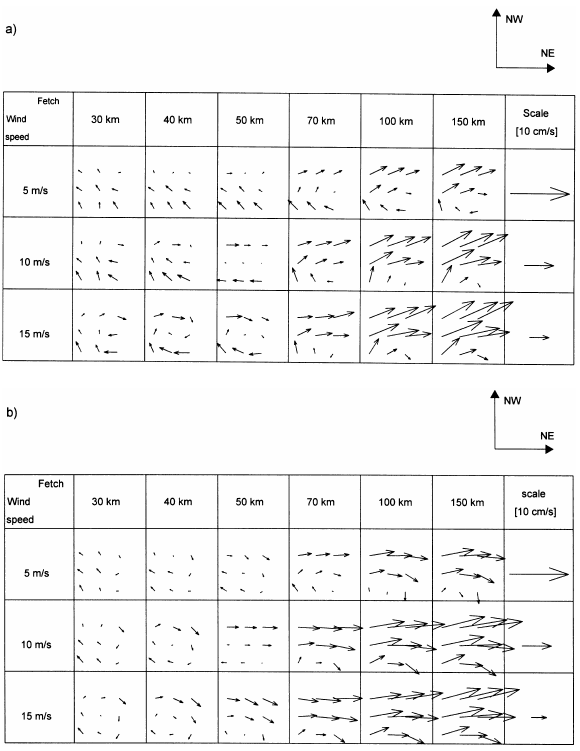
Fig. 4. Surface currents ( a ) and currents at the seventh sigma level ( b ) in the area corresponding to the position of the gas field Ivana, obtained in the numerical experiments with climatological bora pro- files calibrated to speeds of 5, 10 and 15m/s at the Pula station and fetches of 30, 40, 50, 70, 100 and 150km.